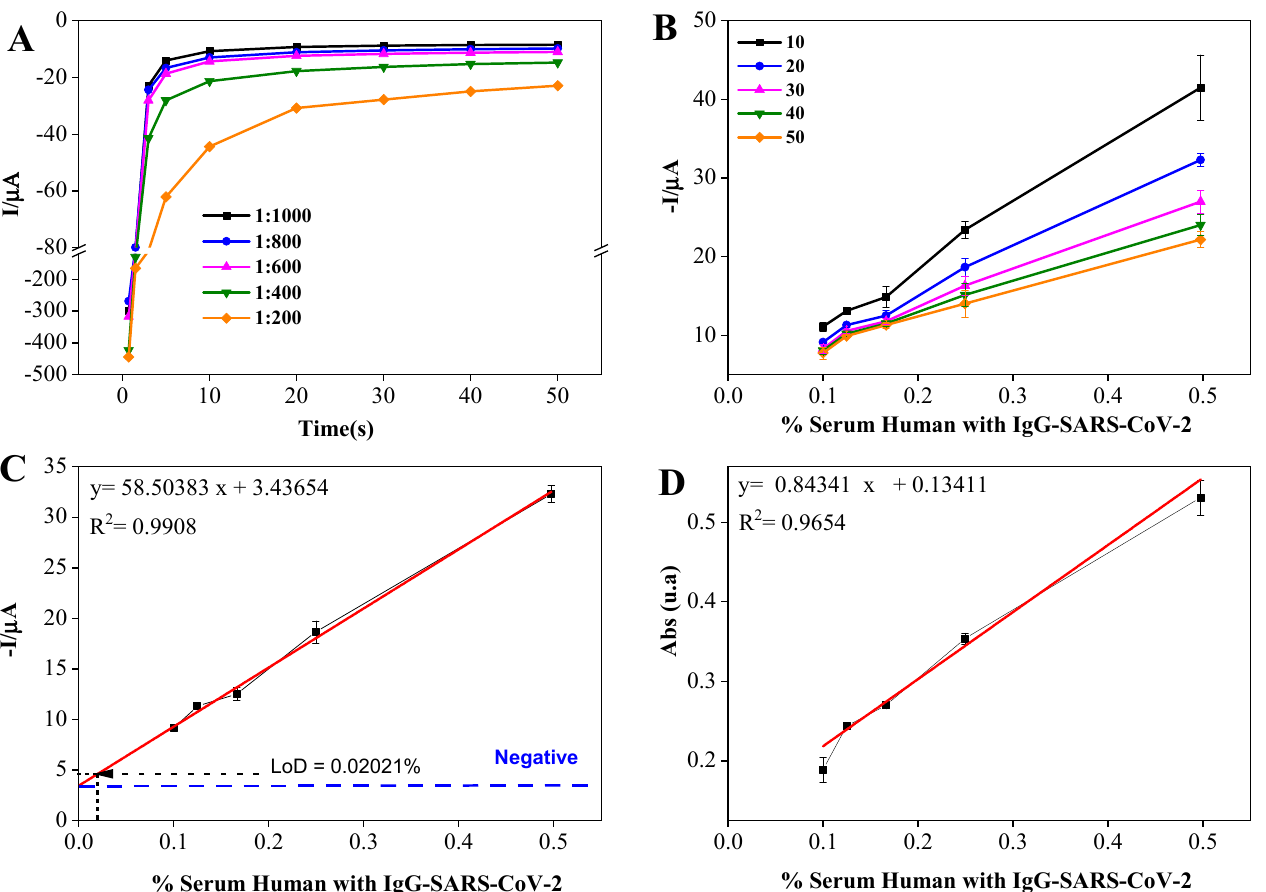
Figure 6. ( A ) Chronoamperometric response measured for different concentrations of human serum with IgG-SARS-CoV-2; ( B ) current values registered from 10 to 50 s for different concentrations of serum human with IgG-SARS-CoV-2; calibration curve for IgG-SARS-CoV-2 determination through ( C ) CA technique and ( D ) ELISA technique. Standard error bars correspond to measurements made on three replicates of each concentration ( n = 3).